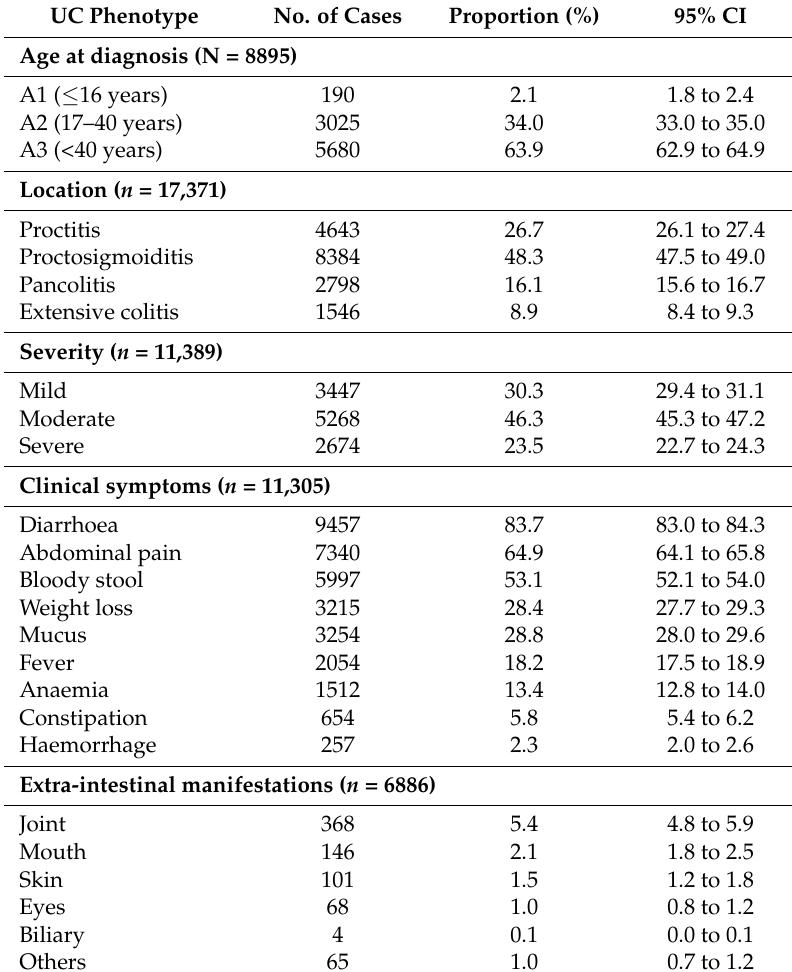
Table 2. The phenotypic and clinical characteristics of ulcerative